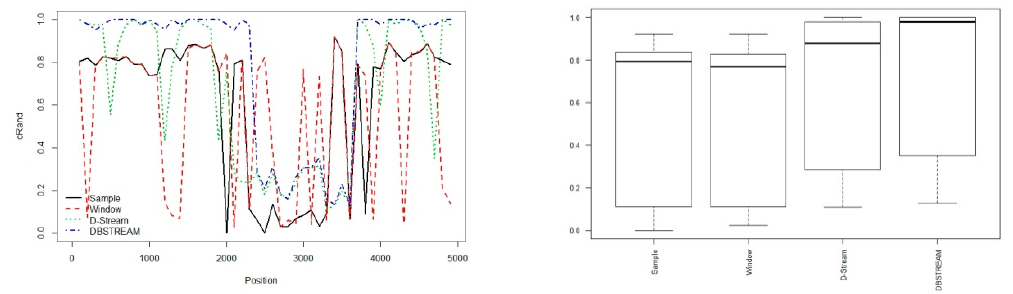
Figure 6. Evaluation of data stream clustering of an evolving stream.